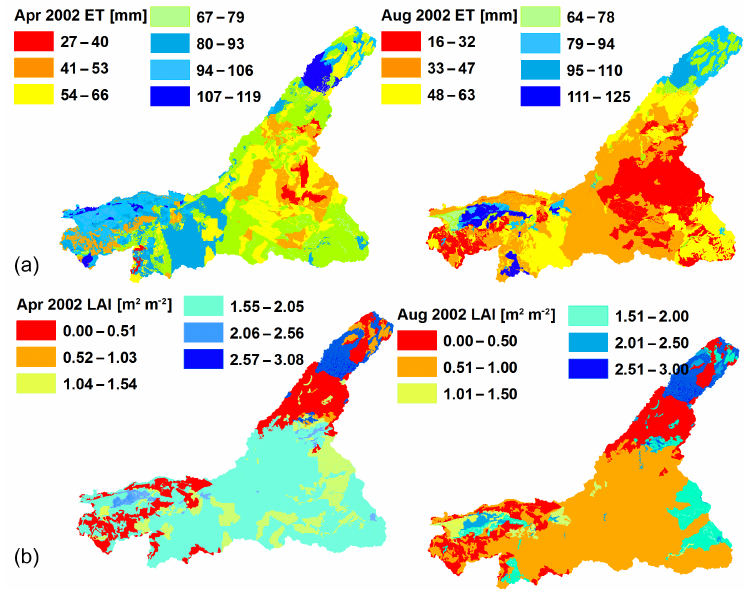
Figure 11. SWAT-T-simulated monthly ET (a) and LAI (b) for April (wet) and August (dry) 2002 at HRU